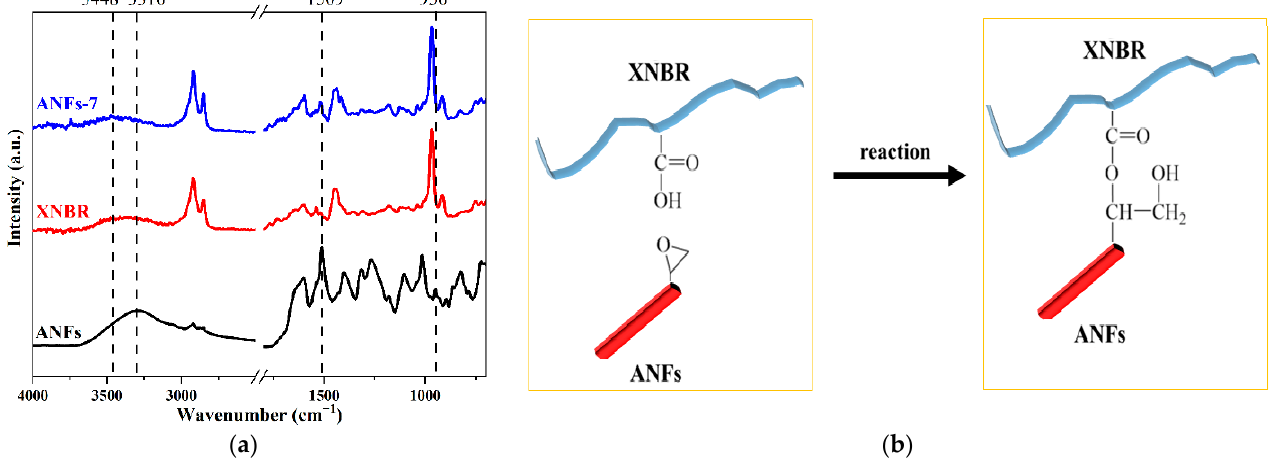
Figure 2. ( a ) FTIR spectra of ANFs and ANF/XNBR nanocomposites; ( b ) reaction between ANFs and XNBR.